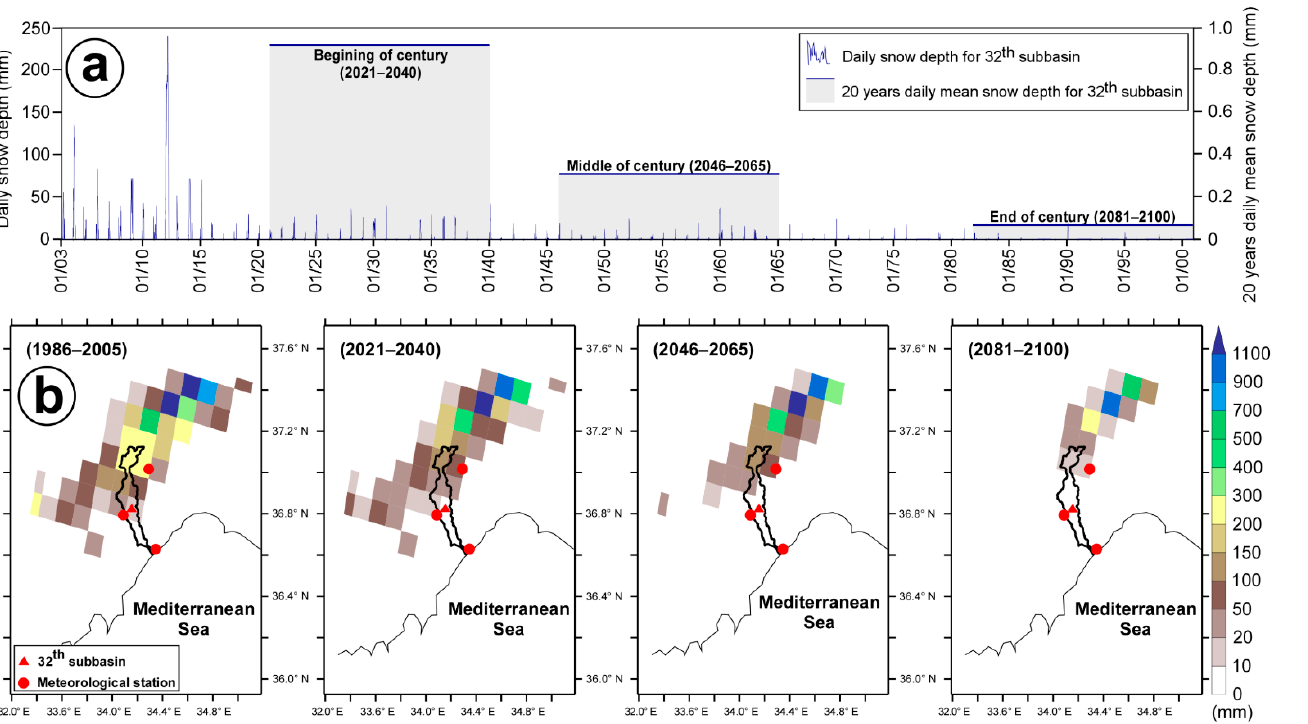
Figure 10. ( a ) Simulated daily snow depth at the 32th subbasin of ARB (see Figure 2b). Grey shaded area represents the periods of the beginning, middle and end of the century and the horizontal blue line illustrates the value of the daily mean snow depth of each period; ( b ) simulated snow water equivalent ( SWE , in mm) by the DMI-HIRHAM5 climate model for the periods of 1986 – 2005, 2021 – 2040, 2046 – 2065 and 2081 – 2100.